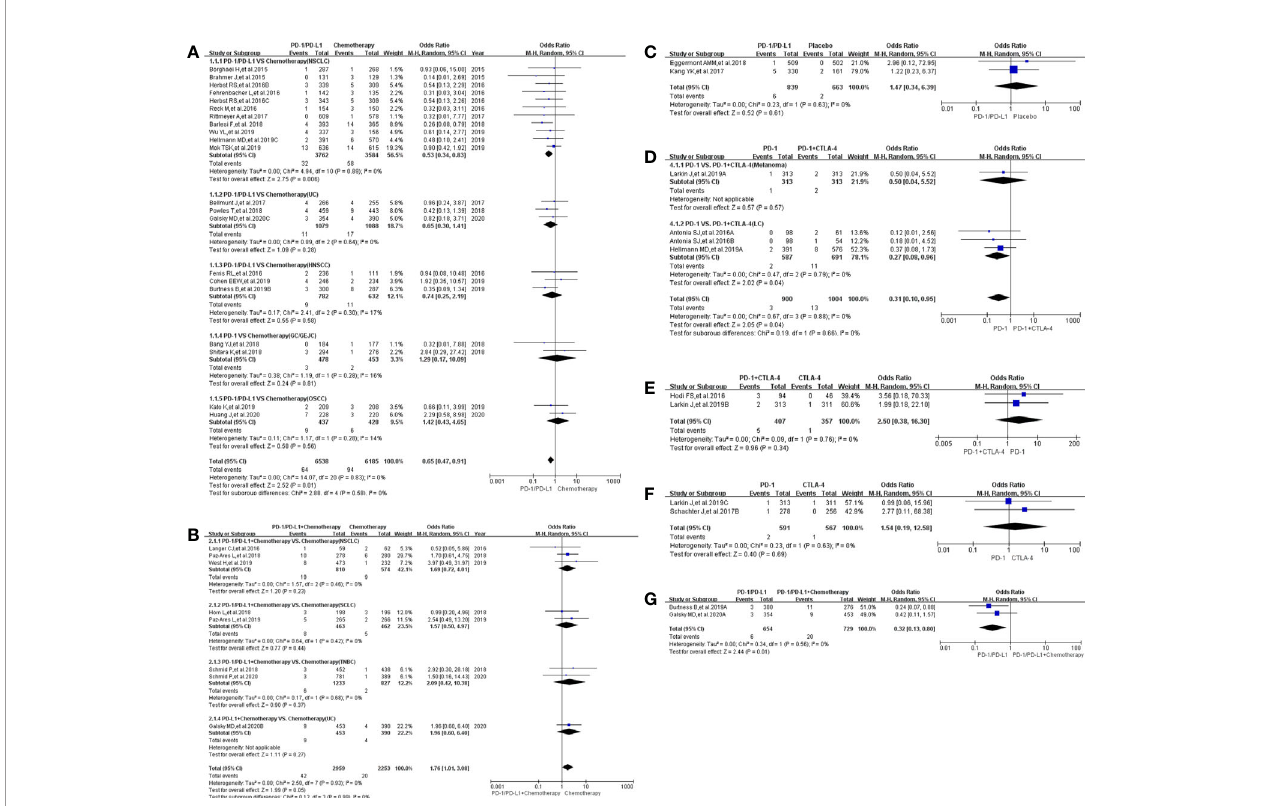
FIGURE 3 | Forest plots of treatment-related adverse events leading to death. (A) The odds ratio of treatment-related adverse events leading to death calculated by the random effect (RE) model in Group A (PD-1/PD-L1 vs Chemotherapy). Subgroup analysis was performed based on tumor types. (B) The odds ratio of treatment- related adverse events leading to death calculated by the random effect (RE) model in Group B (PD-1/PD-L1 + Chemotherapy vs Chemotherapy). Subgroup analysis was performed based on tumor types. (C) The odds ratio of treatment-related adverse events leading to death calculated by the random effect (RE) model in Group C (PD-1/PD-L1 vs Placebo). (D) The odds ratio of treatment-related adverse events leading to death calculated by the random effect (RE) model in Group D (PD-1 vs PD-1 + CTLA-4). Subgroup analysis was performed based on tumor types. (E) The odds ratio of treatment-related adverse events leading to death calculated by the random effect (RE) model in Group E (PD-1 + CTLA-4 vs CTLA-4). (F) The odds ratio of treatment-related adverse events leading to death calculated by the random effect (RE) model in Group F (PD-1 vs CTLA-4). (G) The odds ratio of treatment-related adverse events leading to death calculated by the random effect (RE) model in Group G (PD-1/PD-L1 vs PD-1/PD-L1 +